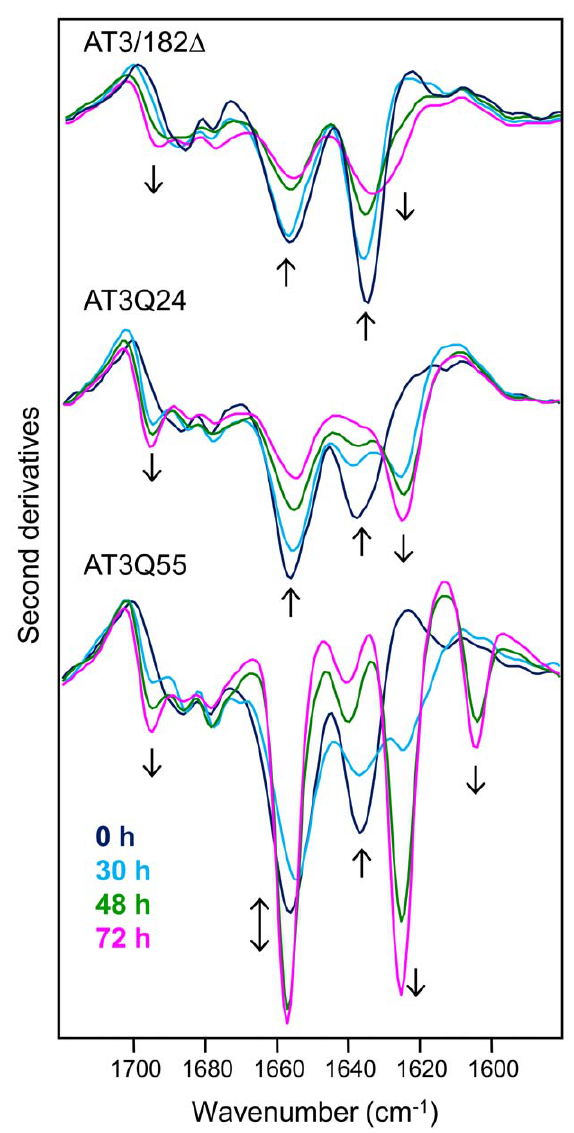
Figure 3. Kinetics of aggregation of AT3 variants monitored by FTIR spectroscopy. Second derivative spectra of AT3 variants were taken at different times of incubation in PBS at 37 u C. Arrows point to increasing